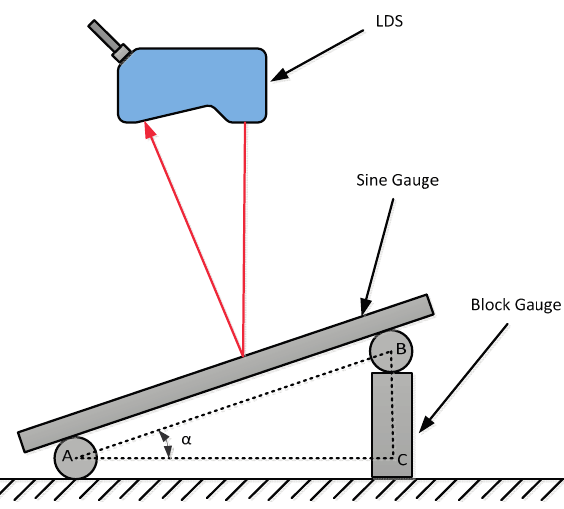
Figure 7. Schematic diagram of Inclination error experiments.